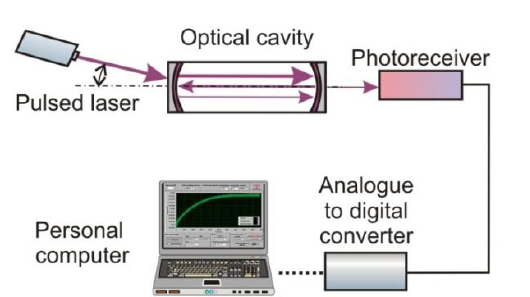
Figure 2. The scheme of the CEAS